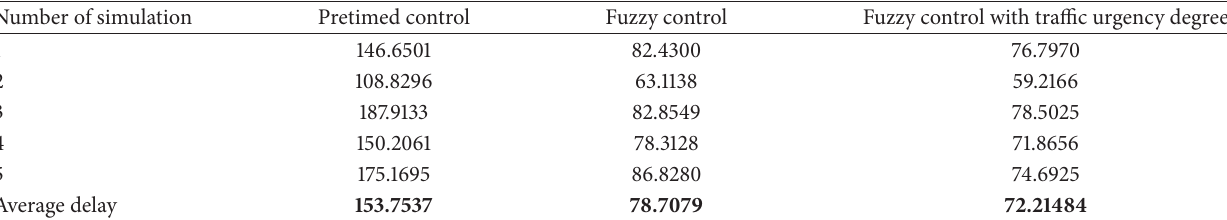
Table 4: Average vehicle delays of middle traffic